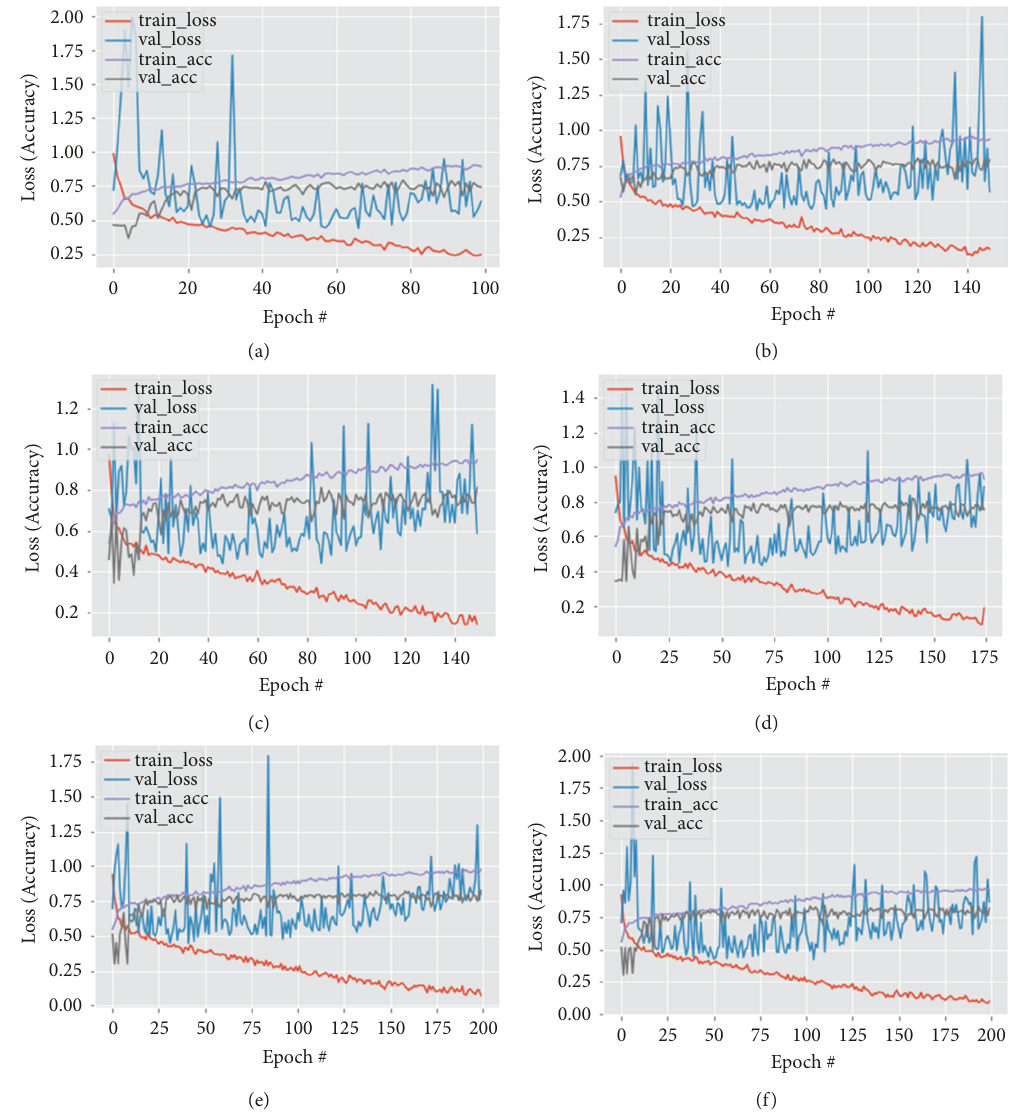
Figure 10: Epochs and validation accuracy difference comparison. (a) Epochs: 100, validation accuracy: 0.7424. (b) Epochs: 150, validation accuracy: 0.7918. (c) Epochs: 150, validation accuracy: 0.8108. (d) Epochs: 175, validation accuracy: 0.7555. (e) Epochs: 200, validation